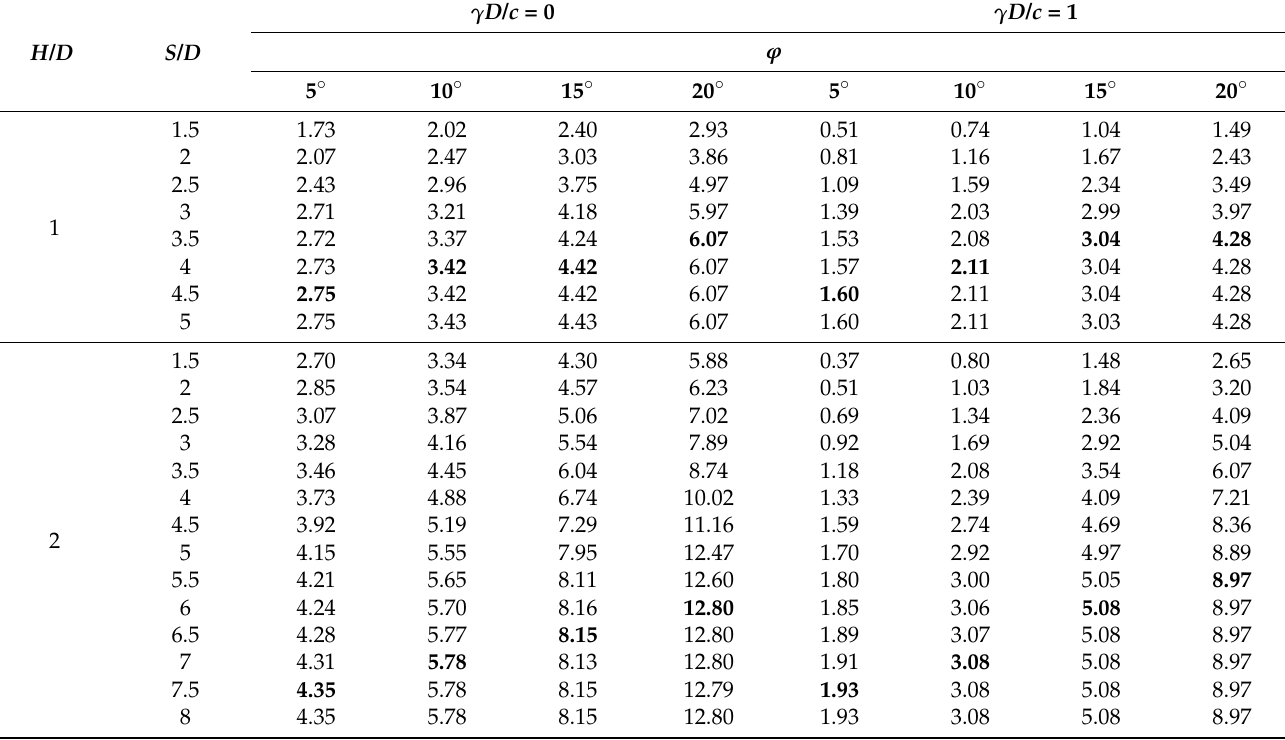
Table 2. Seismic bearing capacity N cs with k h =